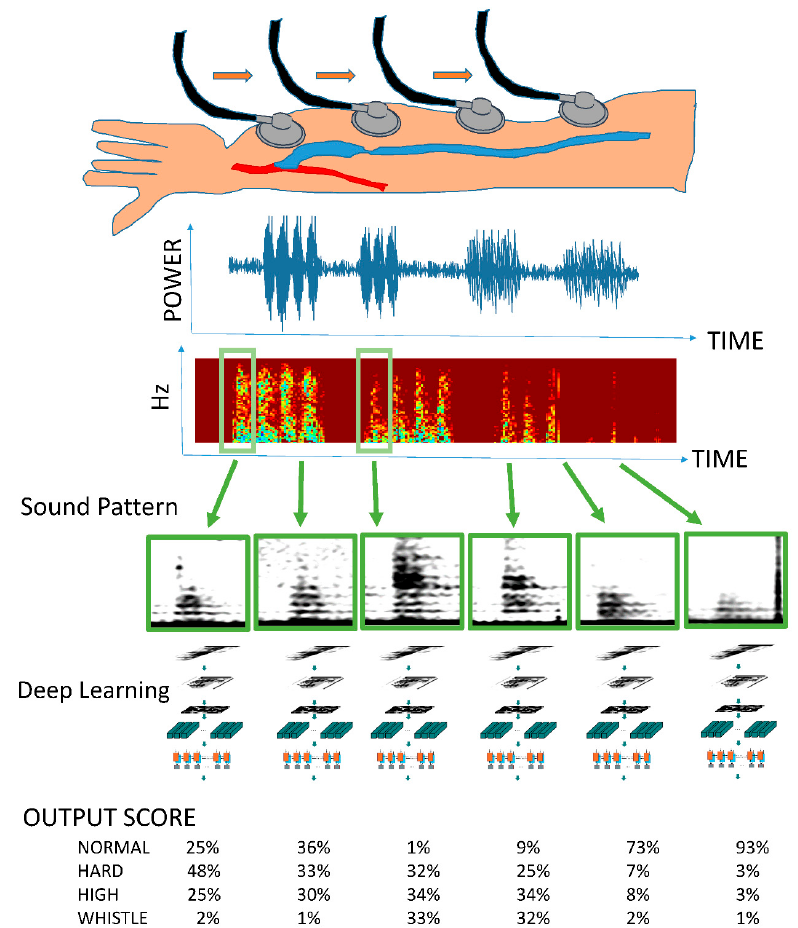
Figure 1. Outline of the arteriovenous fistula sound learning model. A series of arteriovenous fistula sounds are recorded in one medical examination. All continuous tones are converted into spectrograms. A single heartbeat is detected using the mechanism of object detection (R-CNN: regions with convolutional neural networks) similar to that used for face detection in digital cameras and smartphones. The spectrogram of one arteriovenous fistula sound is used as input data. A deep learning model is used for learning, and the importance of the sounds obtained during a general medical examination is expressed by multiclass classification.